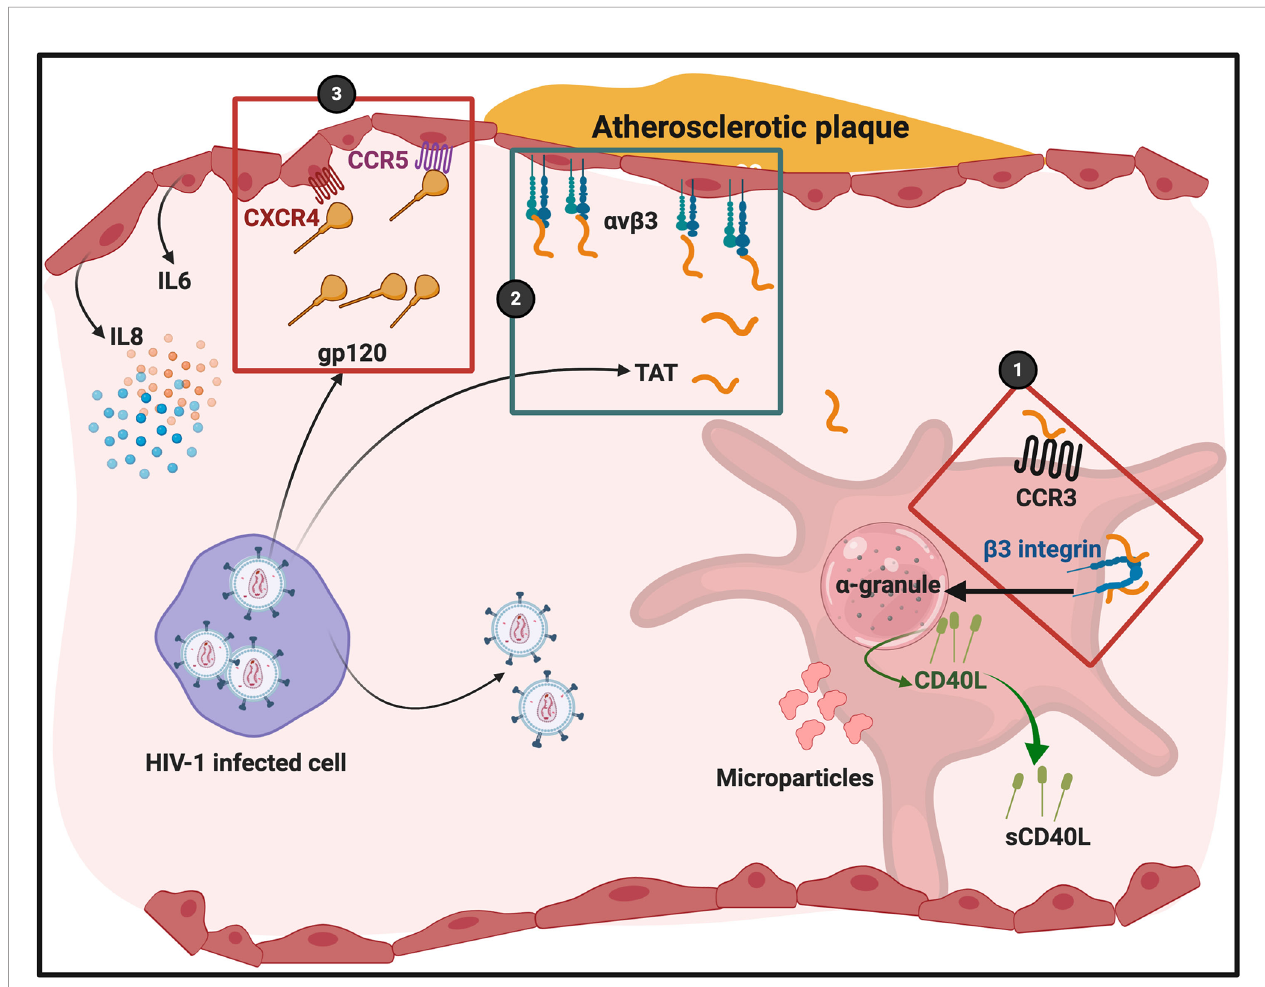
FIGURE 5 | HIV-1 and its trans activating factor (Tat) particles interacting with platelets and endothelial cells. Atherosclerotic plaque formation is known to cause endothelial damage and shown here to indicate an area of endothelial damage. Tat is expressed by HIV-1 infected cells and activates platelets through chemokine receptor CCR3 and integrin b 3 (86) (1). Tat binds to endothelial cell integrin receptor a v b 3 (2). gp120 binds to endothelial cell receptors CXCR4 and CCR5 (3). Diagram created with BioRender (https://biorender.com/). Cells are not drawn to